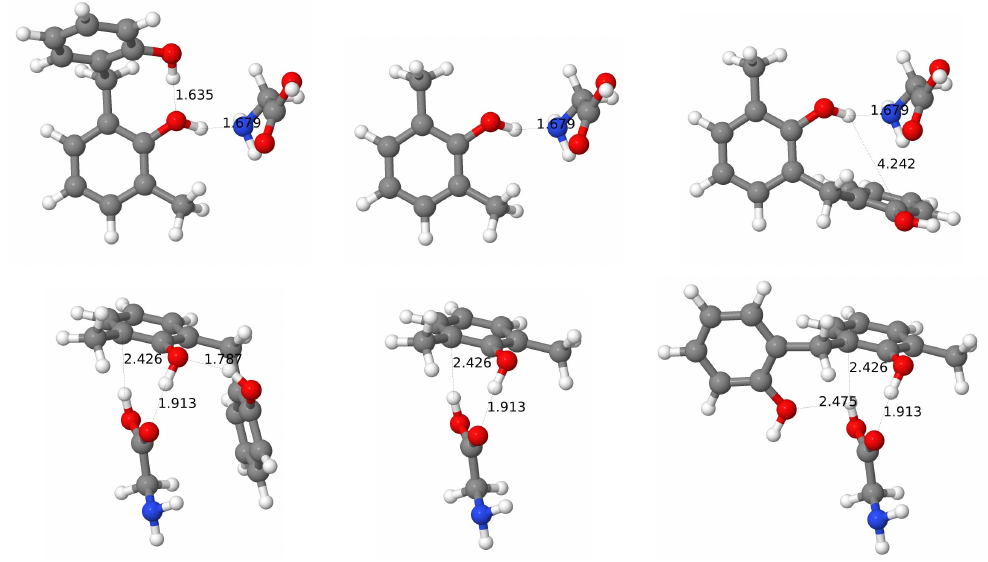
Figure 8. The fragments 1 to 3 and 13 to 15 generated from the SSMF3 partitioning of the al -CX interacting with Gly. The numeration goes row-wise from top left to bottom